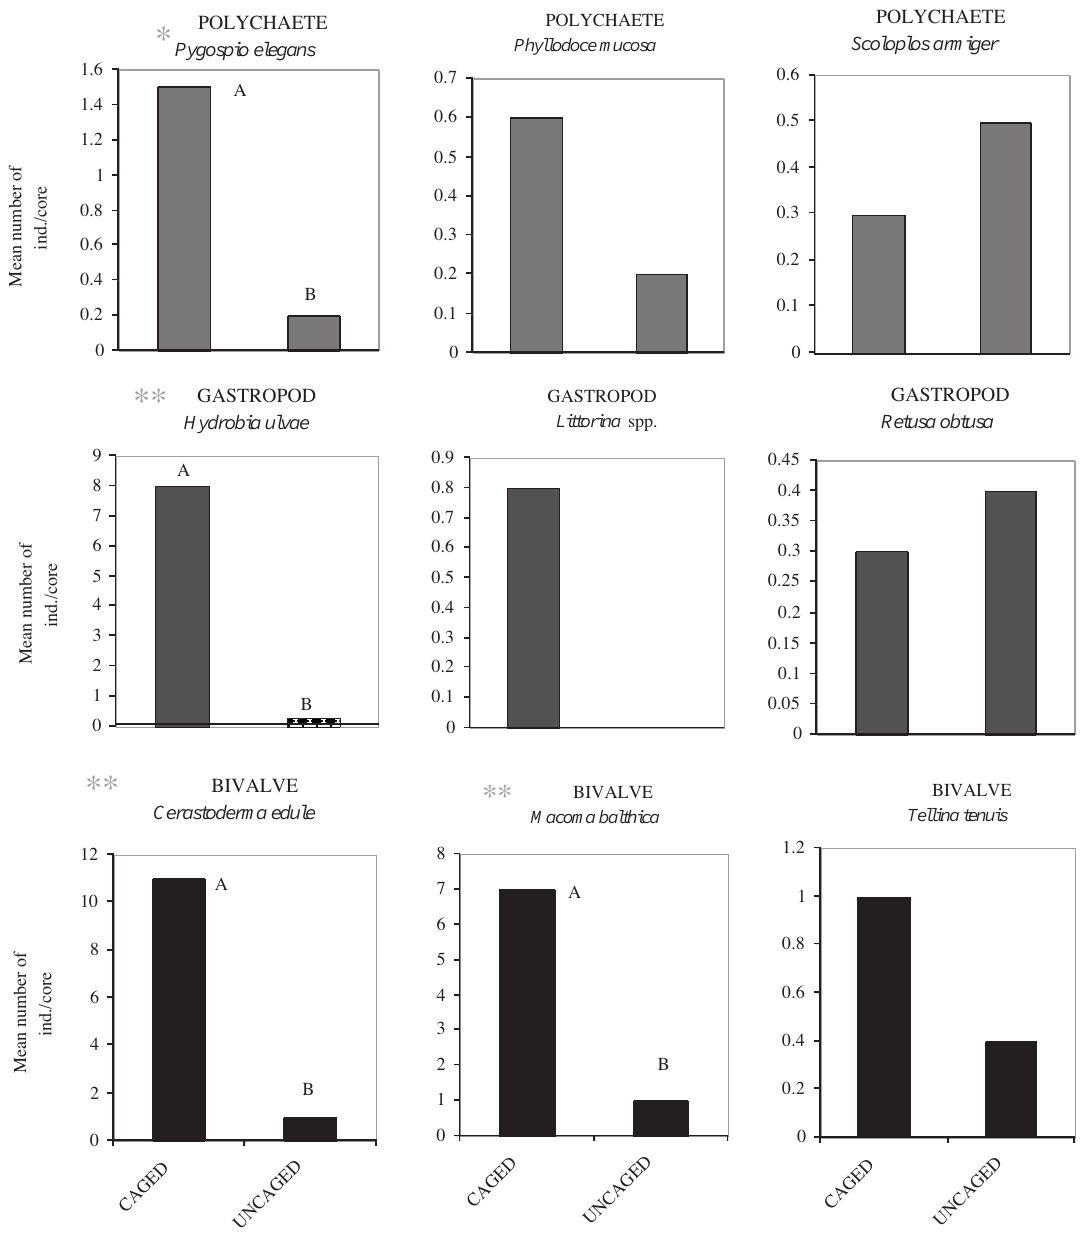
F IG . 6. – Testing effects of overwintering fish Pomatoschistus microps on benthic invertebrate density in winter-spring: absolute frequency of most common benthic invertebrates in caged and uncaged areas (A and B are homogenous subgroups after Tukey’s pairwise